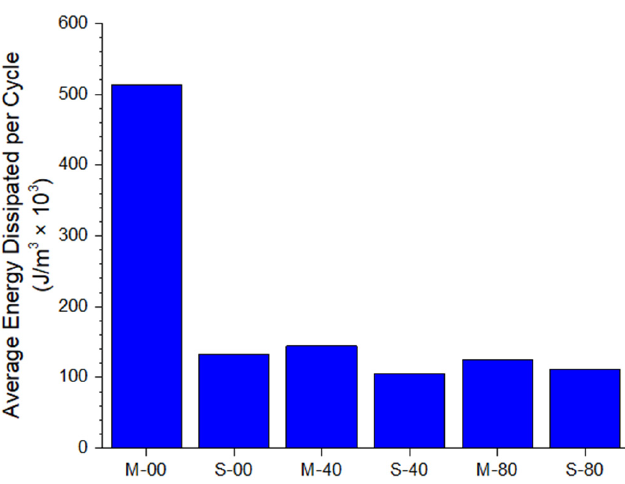
Figure 11. The energy dissipated per cycle of the concrete specimens tested.